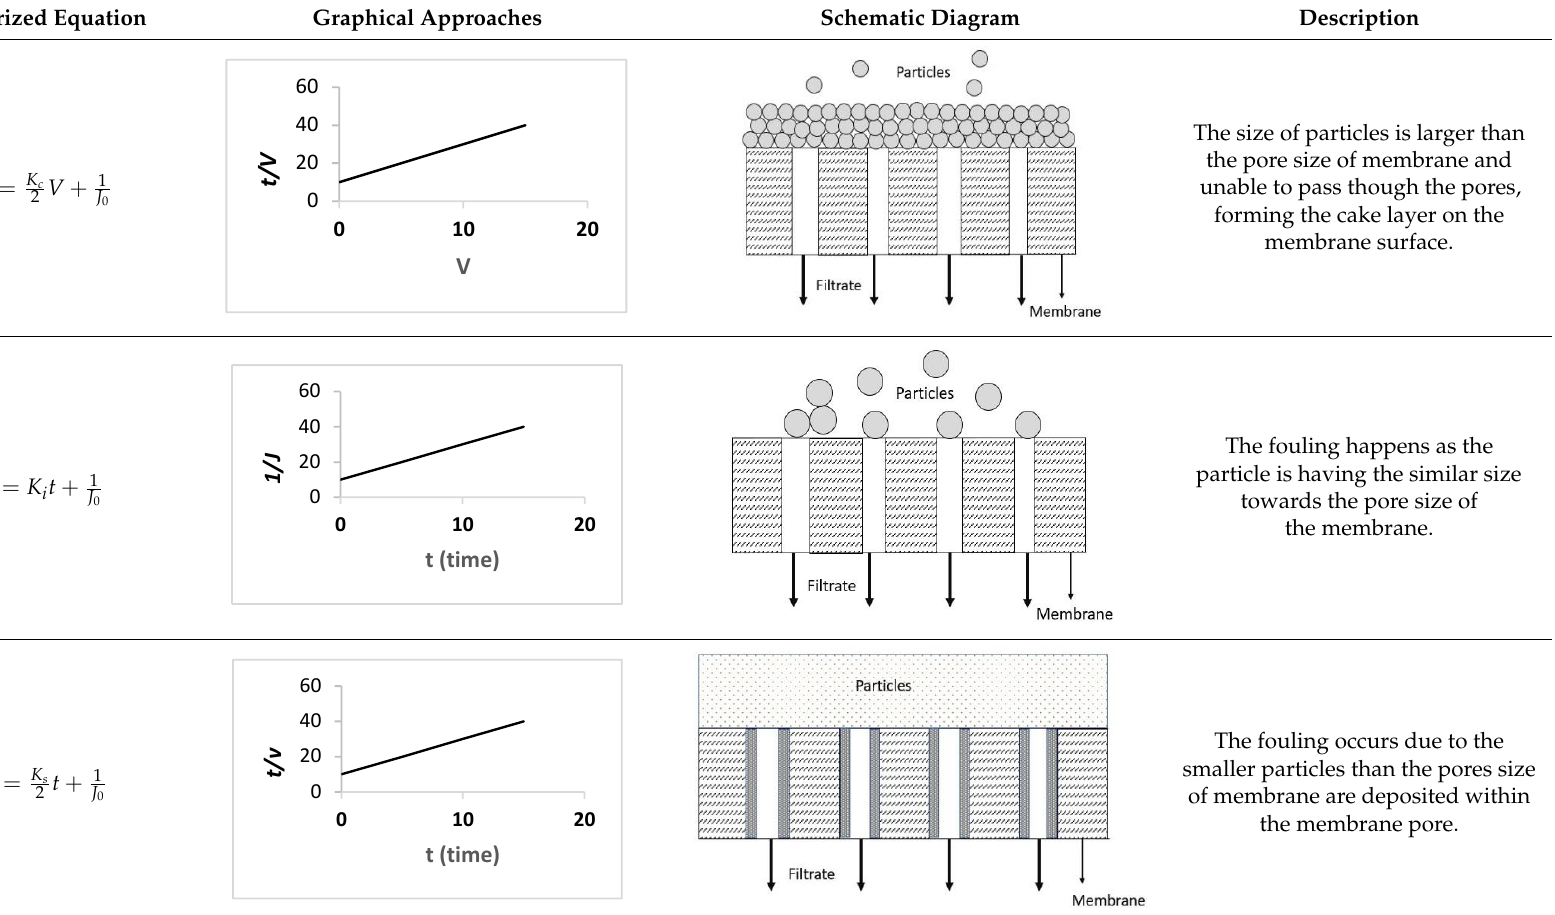
The size of particles is larger than the pore size of membrane and